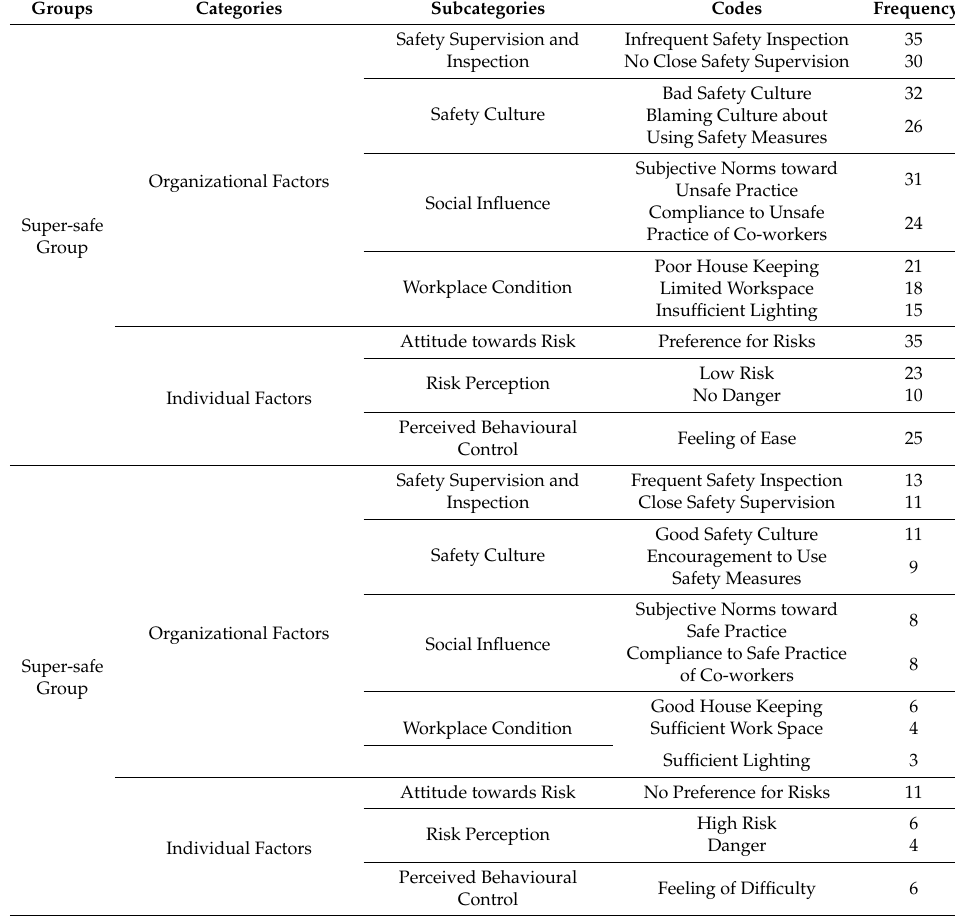
Table 4. Results of coding for the accident group and the super-safe